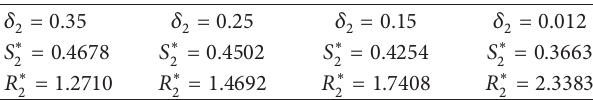
Table 2: Values of (𝑆 ∗ 2 ,𝑅 ∗ 2 ) , when fixing 𝛿 1 = 0.01 and changing 𝛿 2